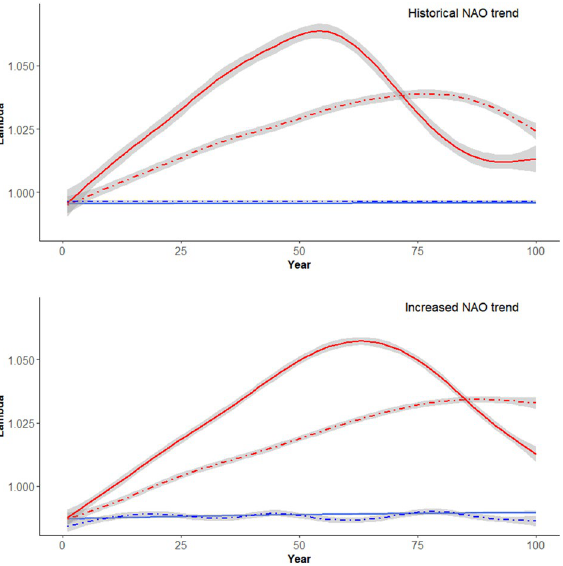
Figure 4. Estimated lambdas, interpreted as instantaneous population growth rate, (y-axis) as a function of time (x-axis) from the projection matrix model. Blue solid lines represent a status quo scenario with no temperature trend, blue dashed lines represent scenarios with no increase in the mean temperature, but with increased annual temperature variation, the red lines represent a climate scenario where annual mean summer temperature increases with 0.04 °C throughout the time frame and dot-dashed red lines represent expected lambdas during an annual summer temperature increase of 0.02 °C as well as increased annual temperature variation. All lines represent smoothed mean trends from 100 iterations of the respective climate scenario. Shaded areas represent the 95% confidence interval around the smoothed mean. Upper panel